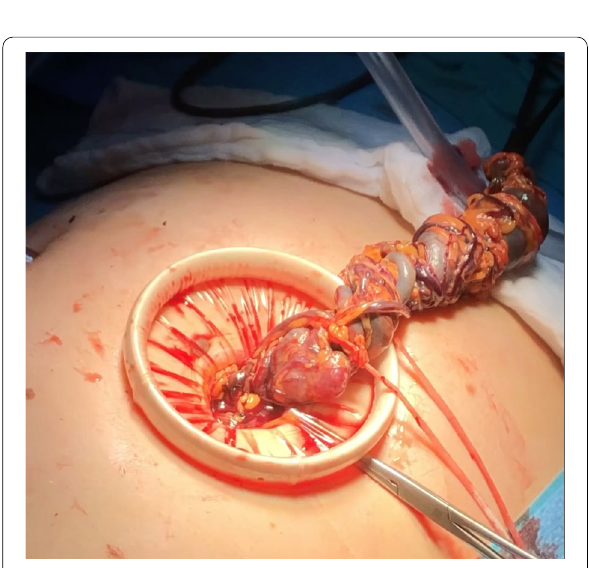
Fig. 3 Interrupted hilar vessels through